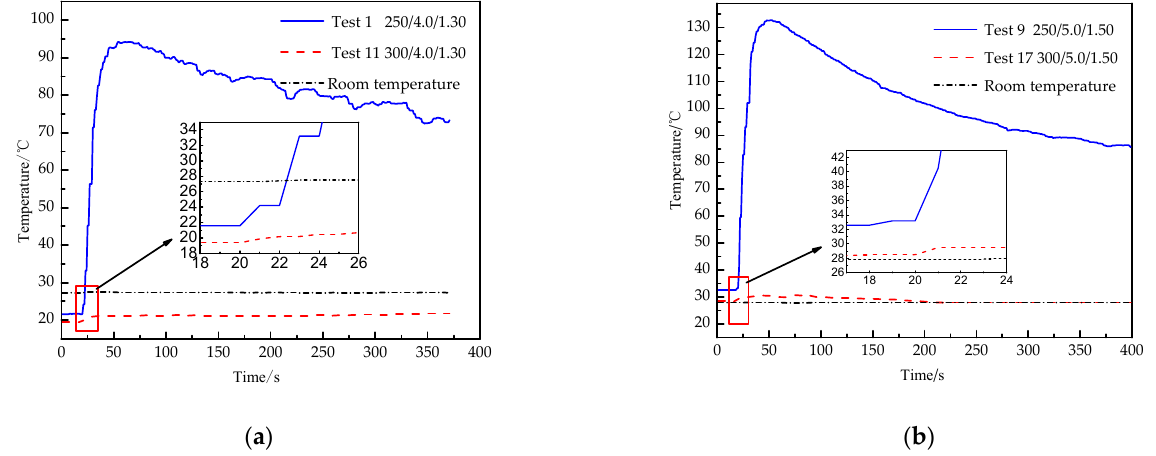
Figure 5. Real-time temperature curve of texts. ( a ). Real-time temperature curve of experiments 1 and 11; ( b ). real-time temperature curve of experiments 9 and 17.